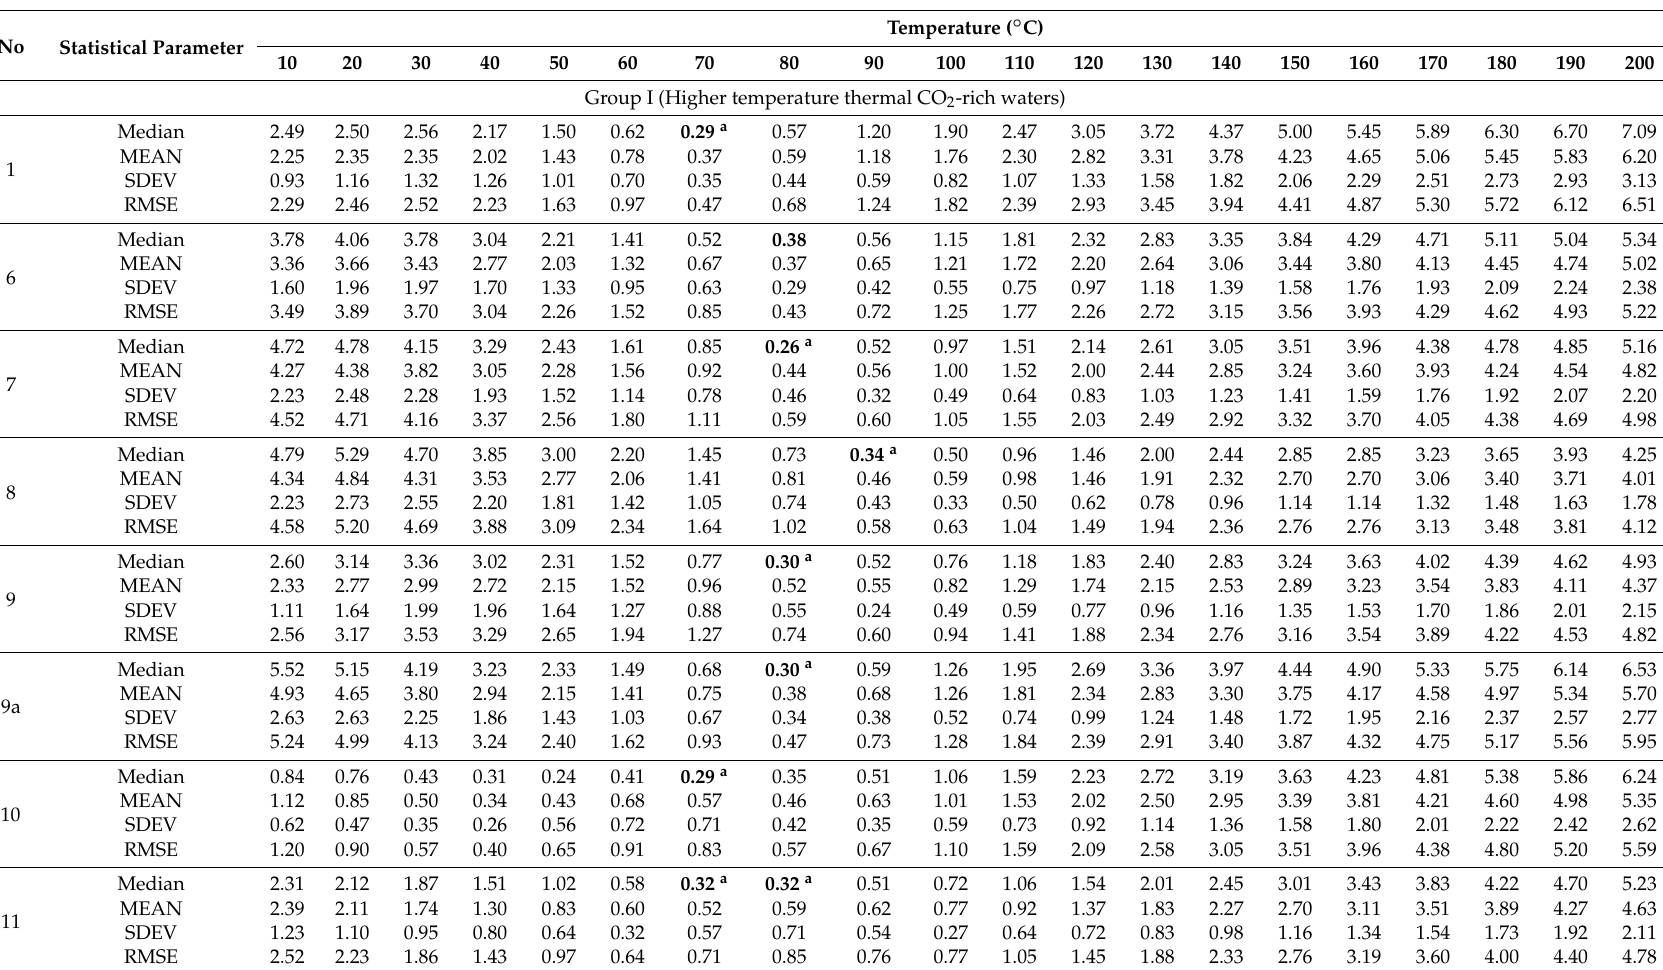
Table 4. Statistical analyses of saturation indices: median, mean standard deviation (SDEV) and mean root square error (RMSE) of absolute log(Q/K) vs. temperature. The estimated temperatures are given by the minimum median of absolute log(Q/K)